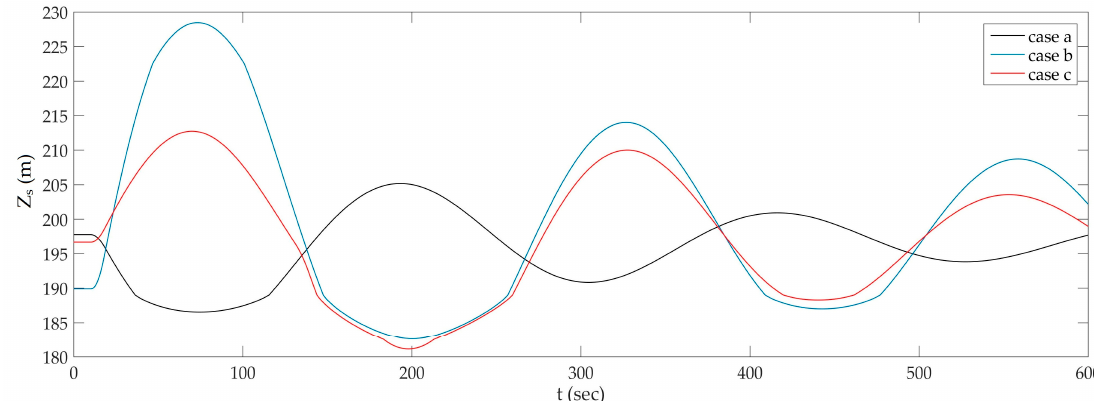
Figure 7. Water level in the surge tank for different cases of downsurge described in Section 2.5.2.